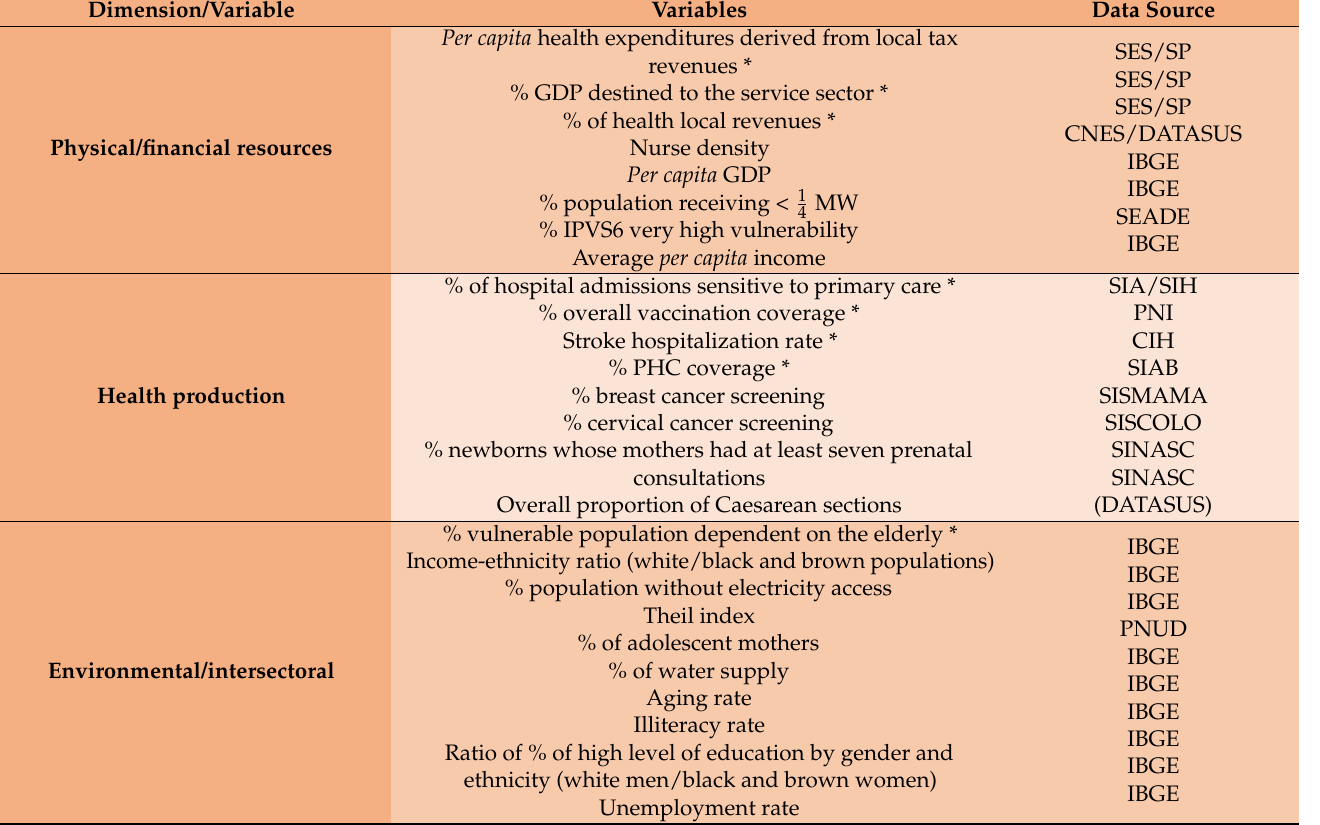
Table 1. Variables tested in the initial models by dimension and data